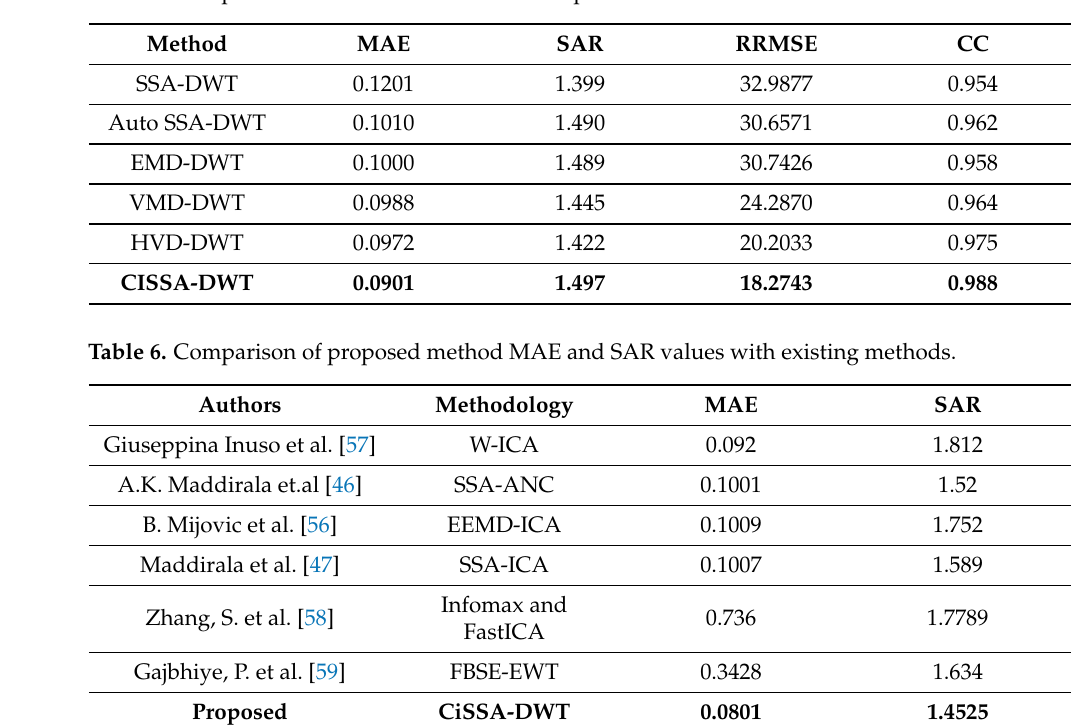
Table 5. Comparison of other data-driven decomposition methods with CiSSA-DWT method.